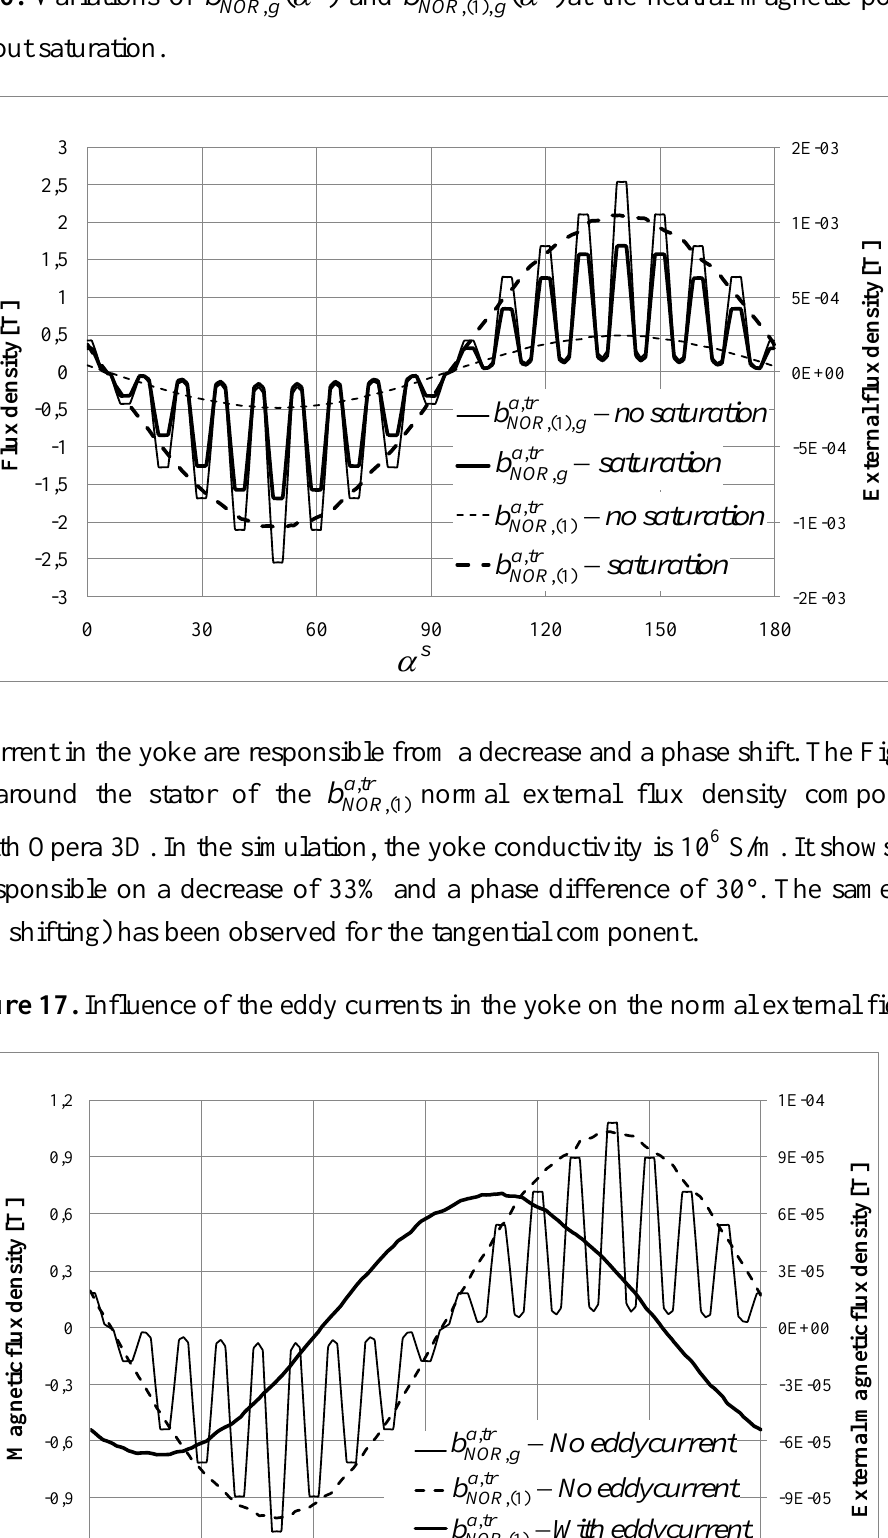
stra stra b  and )( , b  at the neutral magnetic point with , gNOR ),1(, gNOR